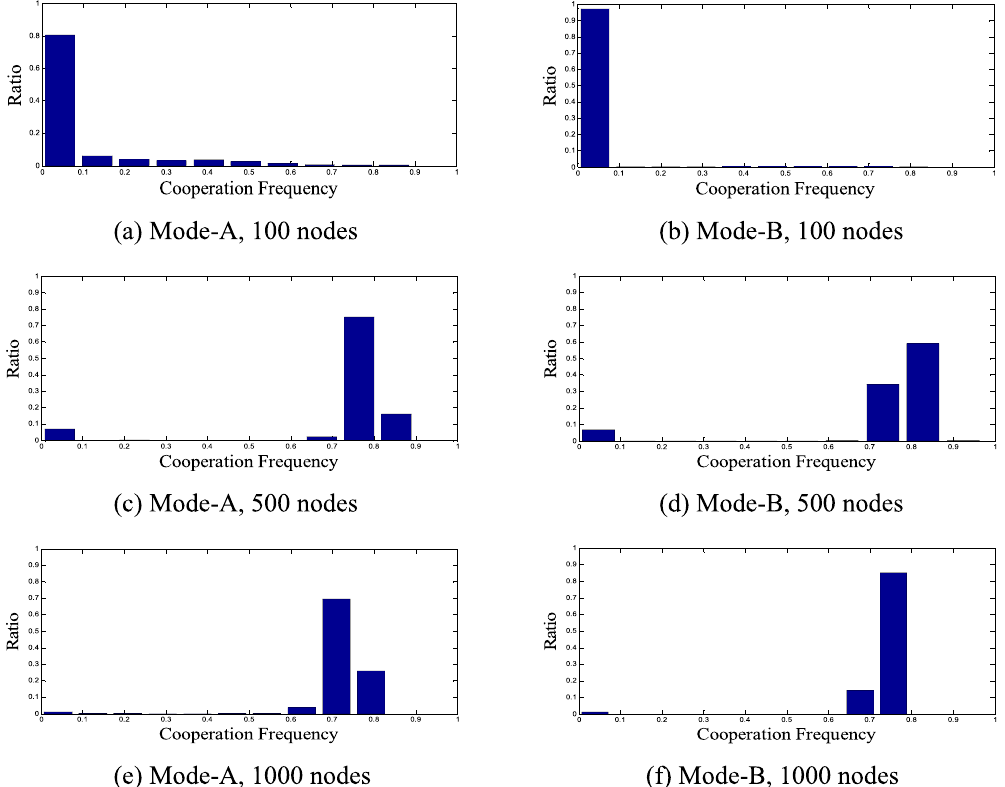
Figure 1. Evaluation distribution of tested population structure (BA network). In this experiment, population structures with different sizes have been tested. It is obvious that the distribution of cooperation frequency obtained under two different evaluation modes is similar (horizontal contrast) and the distribution of cooperation frequency gets broader when size of population gets smaller (vertical